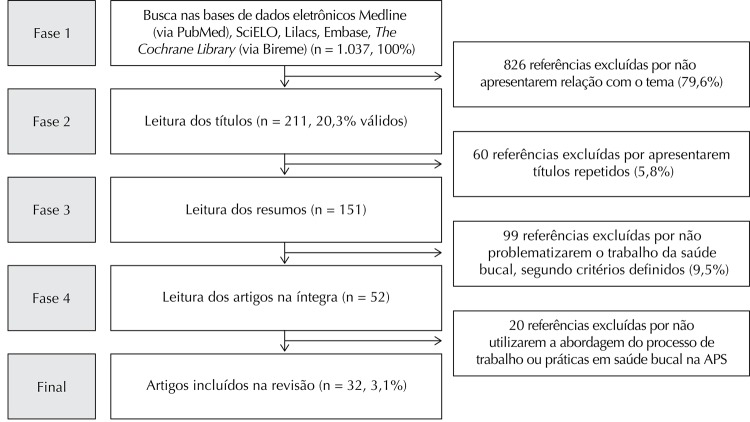
Busca, seleção, inclusão e exclusão dos estudos sobre o processo de trabalho na saúde bucal na Atenção Primária à Saúde.APS: Atenção Primária à Saúde